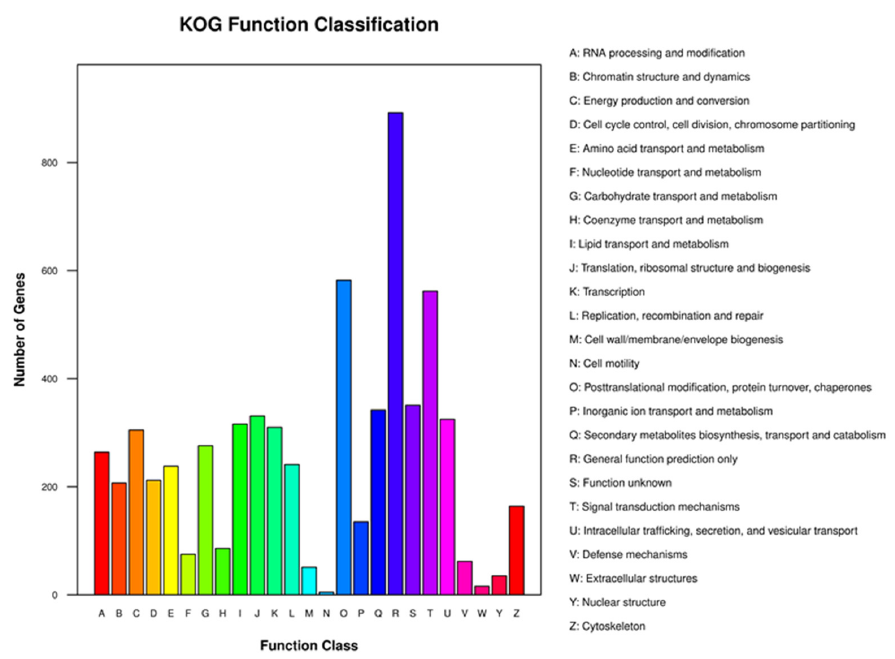
Figure 4. Clusters of the KOG functional classification of C. unicolor SP02 genes. A total of 5595 genes were assigned to 25 classifications. The capital letters on the x-axis indicate the KOG categories as listed on the right of the histogram.